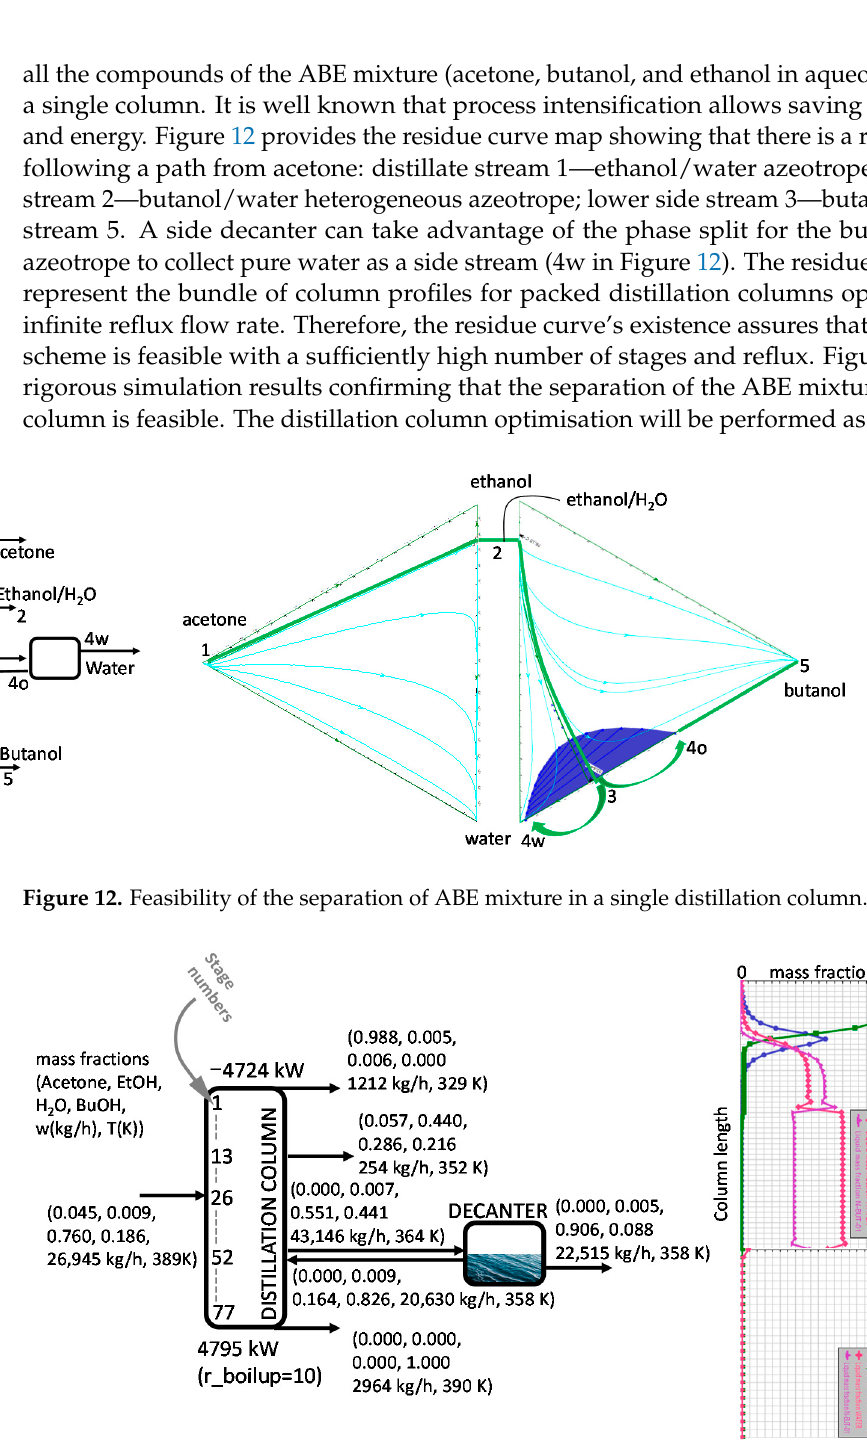
Figure 13. Rigorous simulation results prove the feasibility of a single column